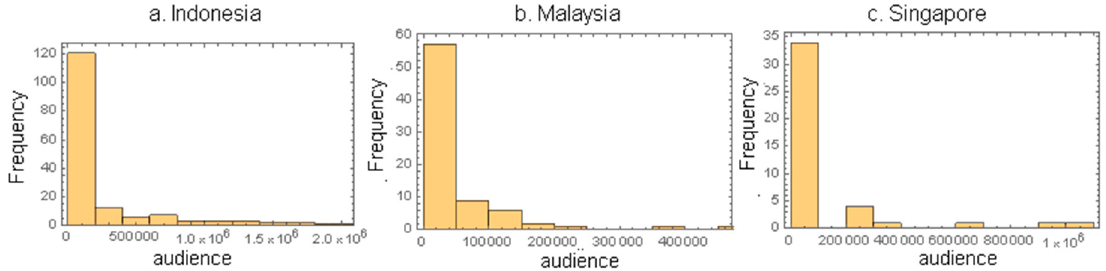
Figure 2. Histogram of Twitter followers for online news media outlets in Indonesia, Malaysia, and Singapore. Table 3. Statistics for online news media networks before and after edges